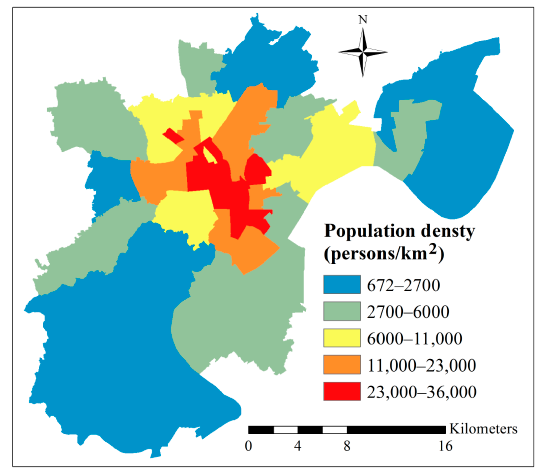
Figure 2. Population density for the street-town unit.